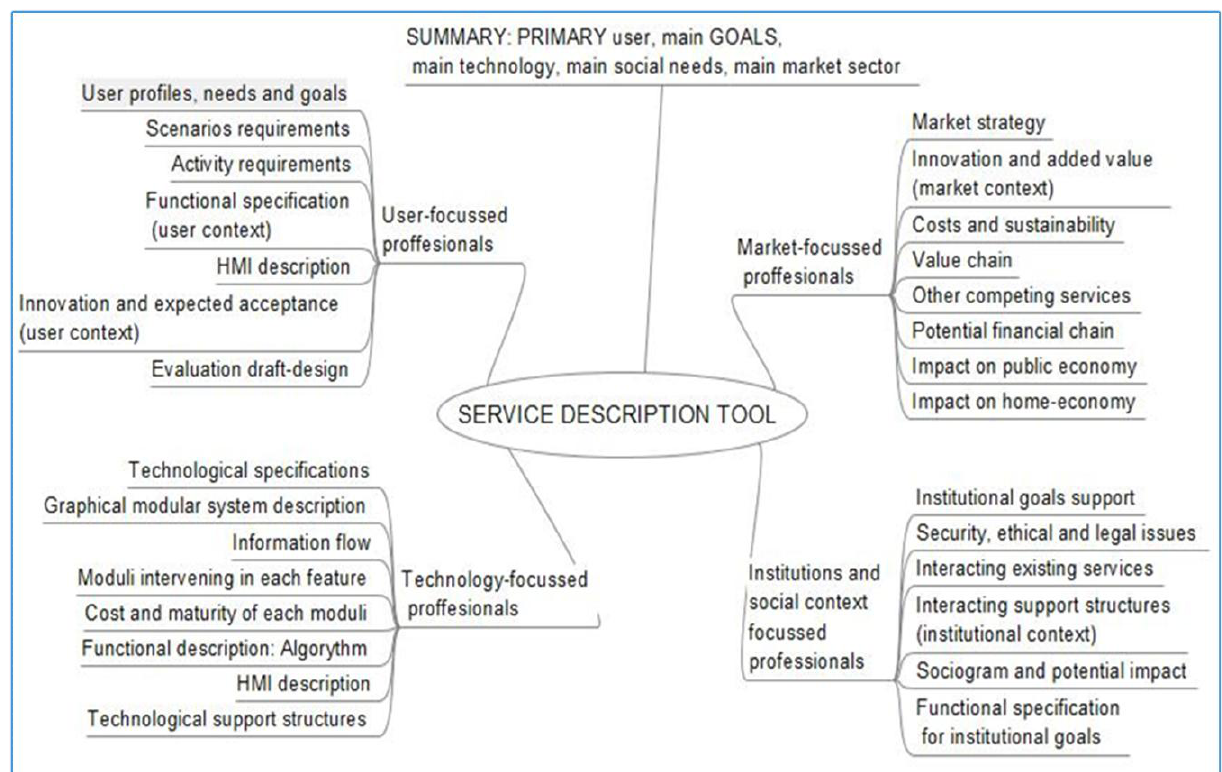
Figure 1. Conceptual map of service description with items or info-bits generated by each professional